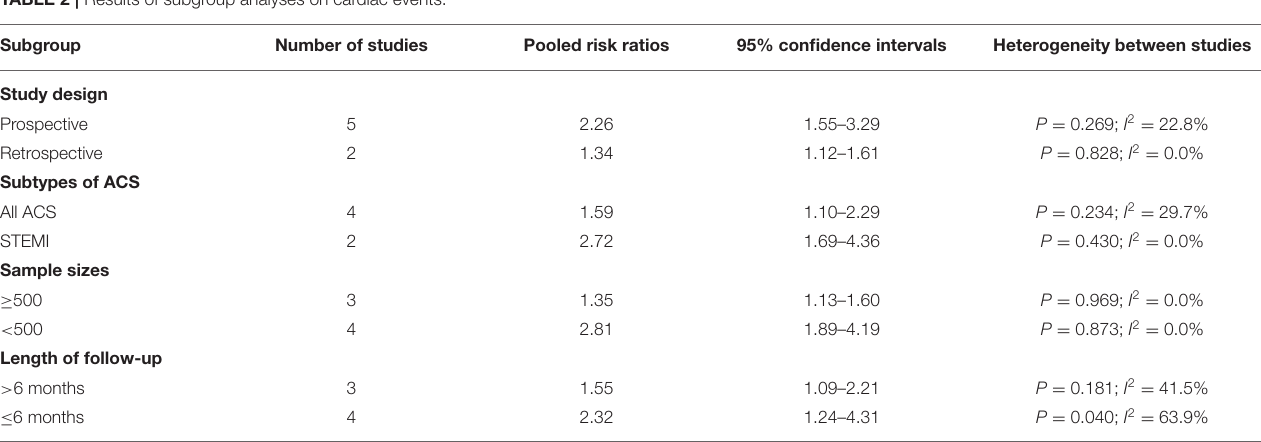
TABLE 2 | Results of subgroup analyses on cardiac